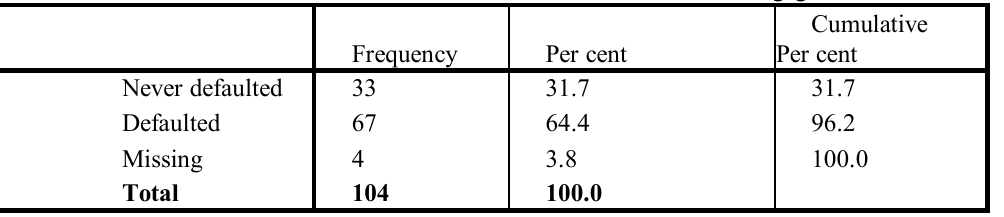
Table 6: Cross tabulation of borrower’s relationship with his or her financier versus Propensity to